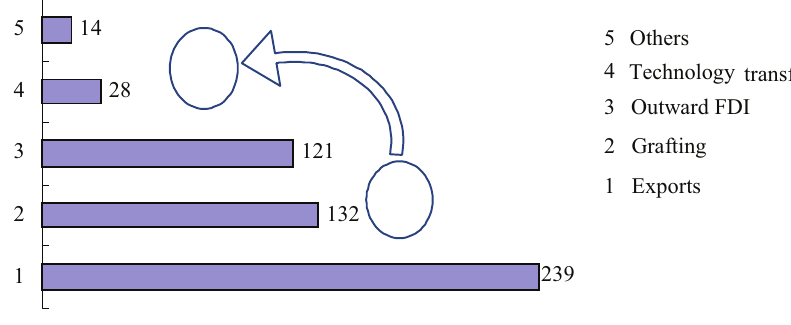
Fig. 1. Terrace structure of firm’s internationalization